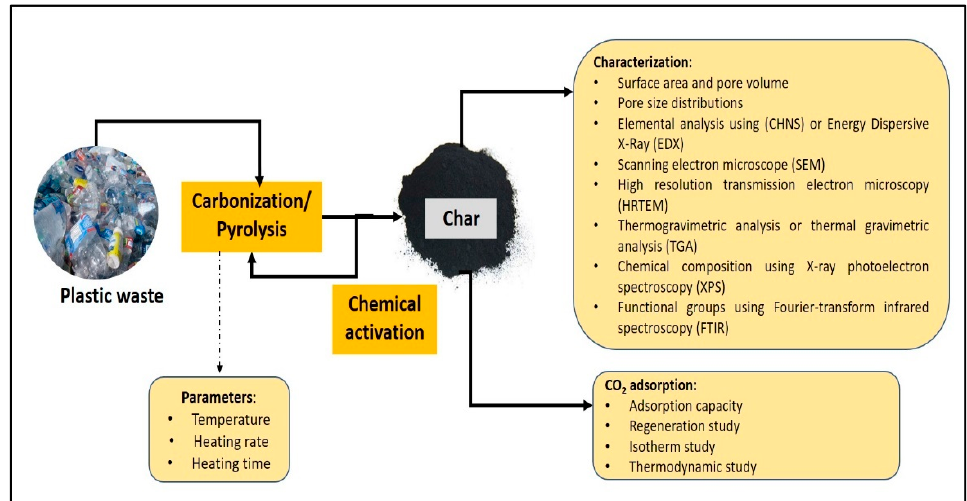
Figure 1. Overall adsorption process using plastic waste as an adsorbent.